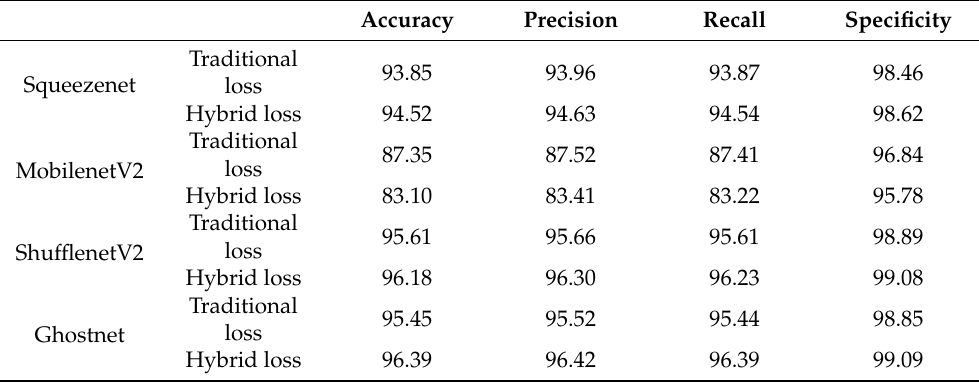
Table 2. The classification performances of four lightweight CNNs with traditional loss and hybrid